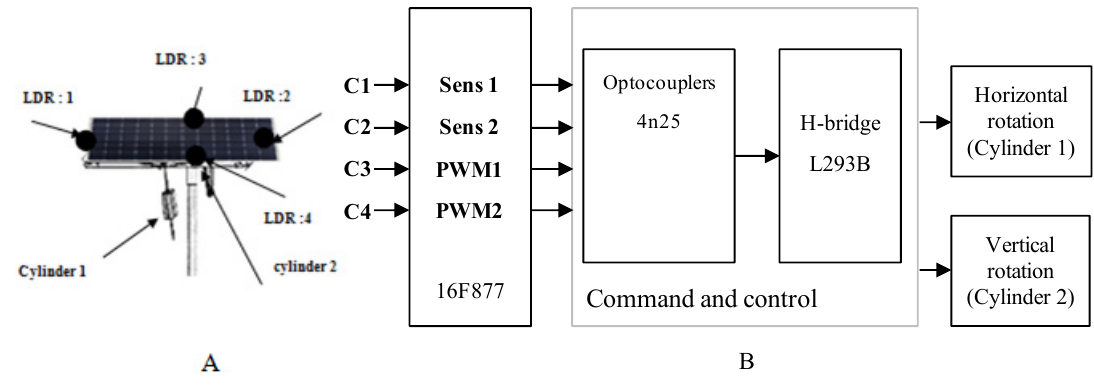
Figure 9. LDR sensor sand mechanical support ( A ), Command and control of the follower of the sun ( B ).